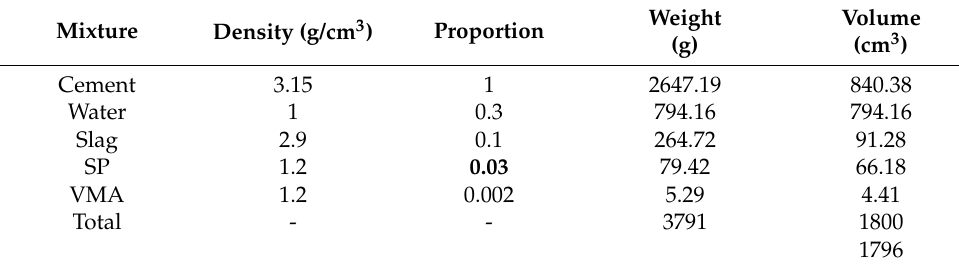
Table 12. GRG optimal mix design.